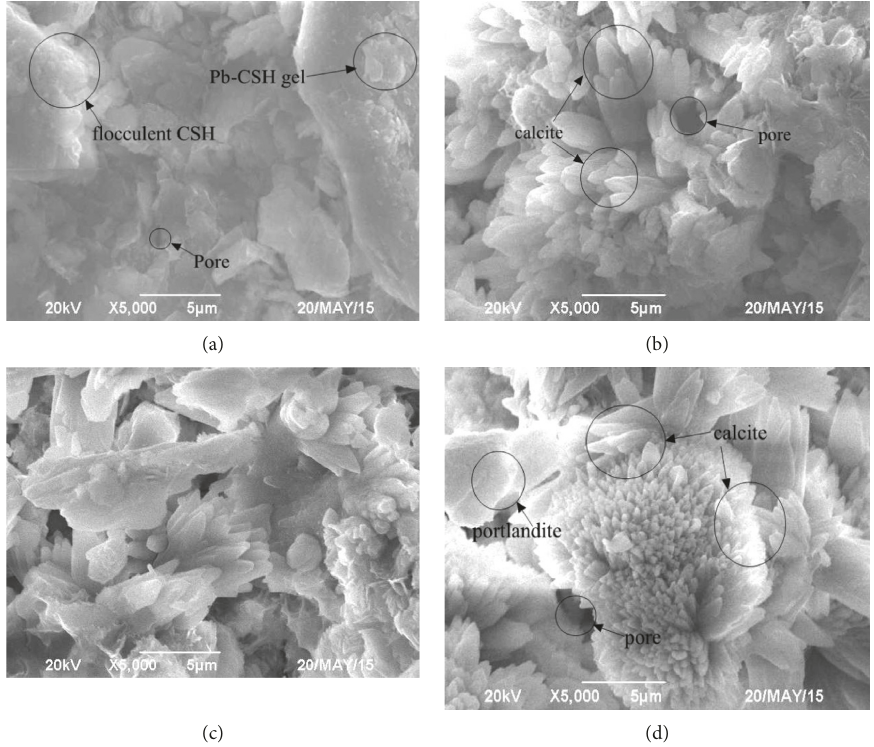
Figure 9: Microstructural characteristics of the specimens tested under different conditions. (a) AR10+Pb1 (28d). (b) AR30 +Pb1 (28 d). (c) AR30 +Pb3 (28d). (d) AR30 +Pb1 (90d).